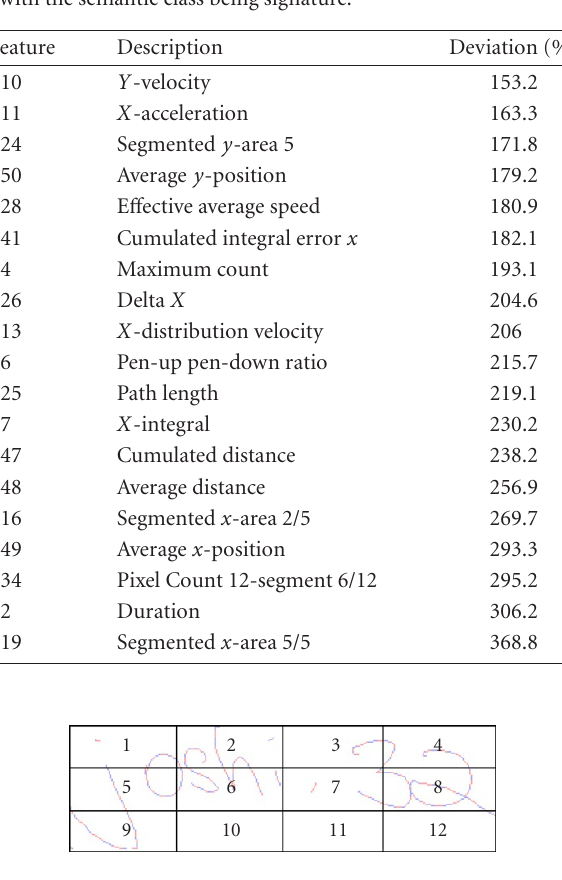
Figure 3: Segmentation of the writing image into 12 equal-sized